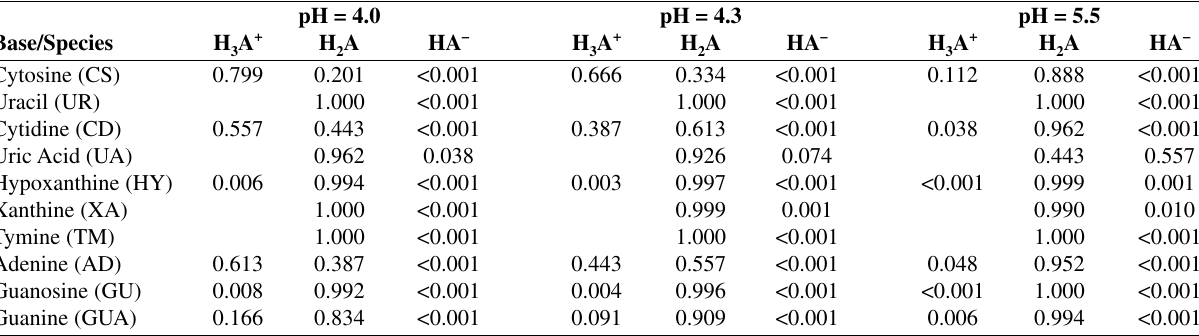
Table 1. Calculated distribution coefficients for nucleobase species at different pH* pH = 4.0 pH = 4.3 Base/Species